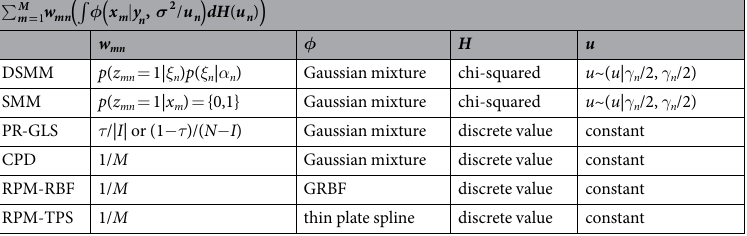
Table 1. Relationship between the general family of mixture model registration and the existing